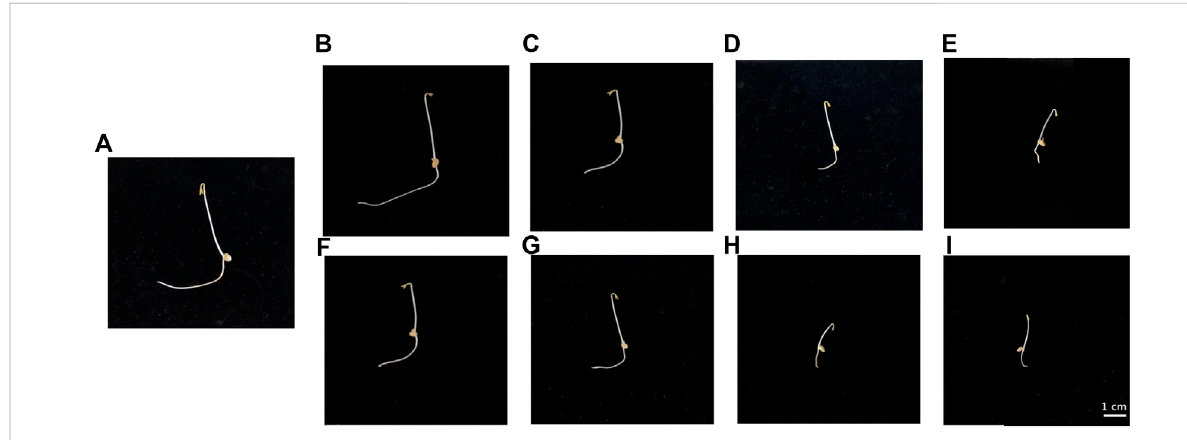
FIGURE 1 Evolution of rootlength inlentilseedlingsfollowing treatment with Ce [ (B) 5 μ M, (C) 25 μ M, (D) 50 μ M, (E) 100 µM]and Nd[ (F) 5 μ M, (G) 25 μ M, (H) 50 μ M, (I) 100 µM] for 3 days. (A) , control.